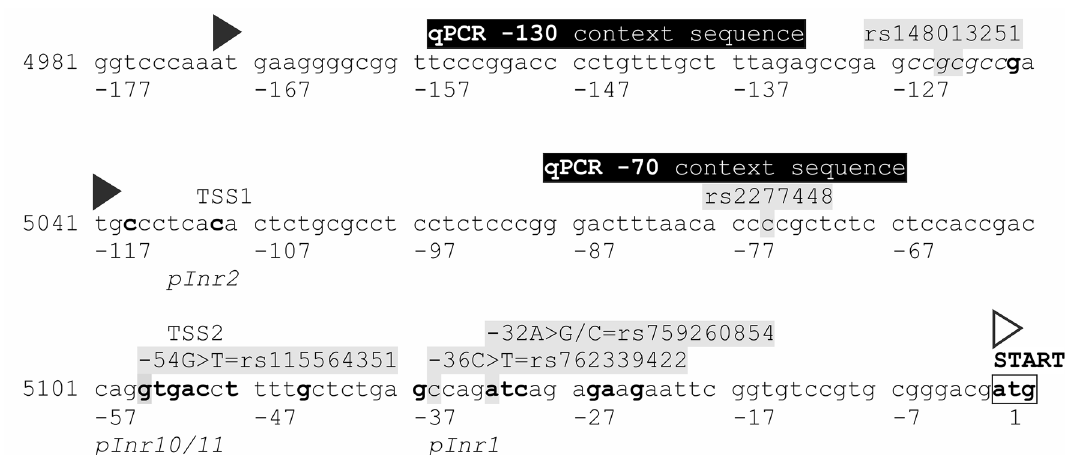
Figure 5. The ATP7B core promoter. Numbers on the left refer to genomic ATP7B reference sequence NG_008806.1, numbers below the DNA sequence are relative positions to the ATP7B start codon. The regular ATG start codon is indicated by an open triangle, irregular start codons (potential uORFs) out of frame by black triangles. Nucleotides in fat and framed are conserved, those with gray shading have been studied as variants in the current analysis. Transcriptional start sites (TSS) as reported in databases are indicated above the sequence. qPCR probe core sequences are indicated in frames above the